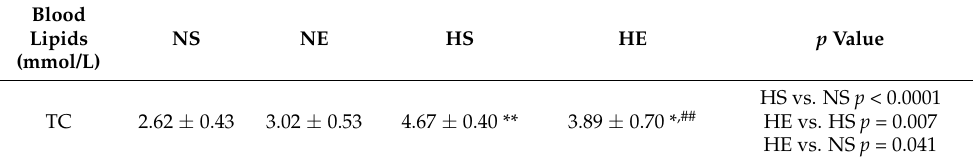
HE vs. HS p = 0.891